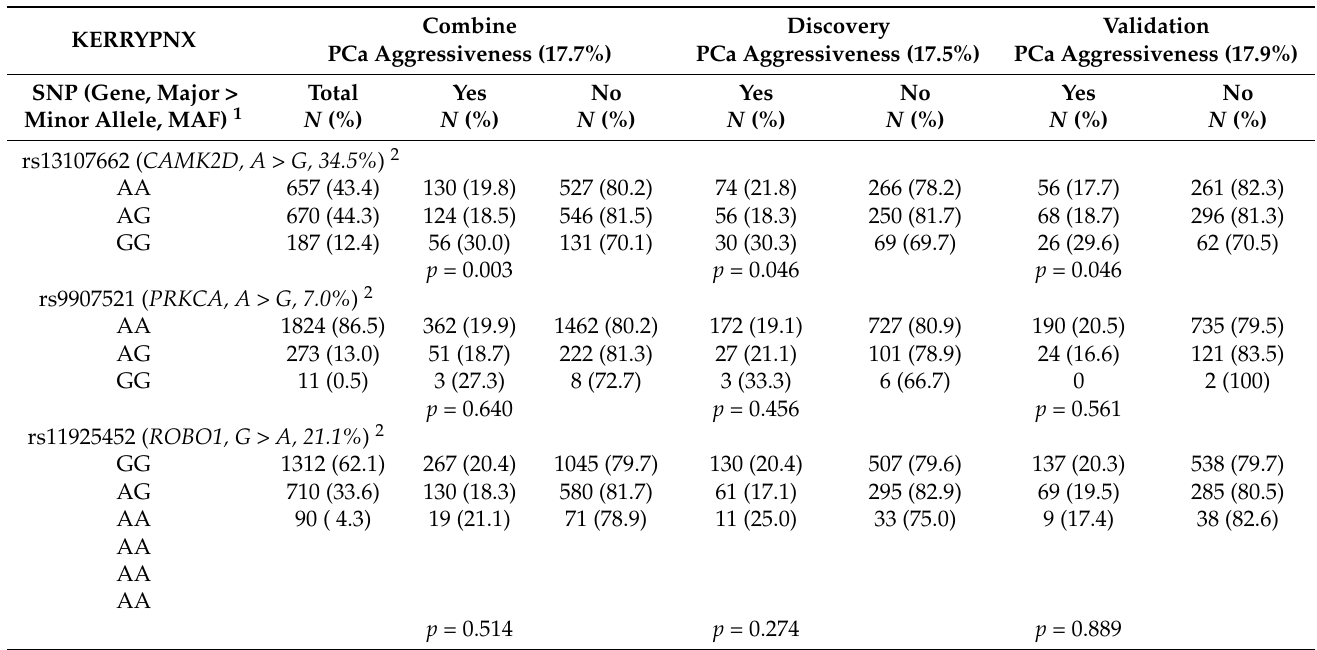
Table 3. SNP individual effects for SNPs involved with alcohol–SNP interactions associated with prostate cancer (PCa)